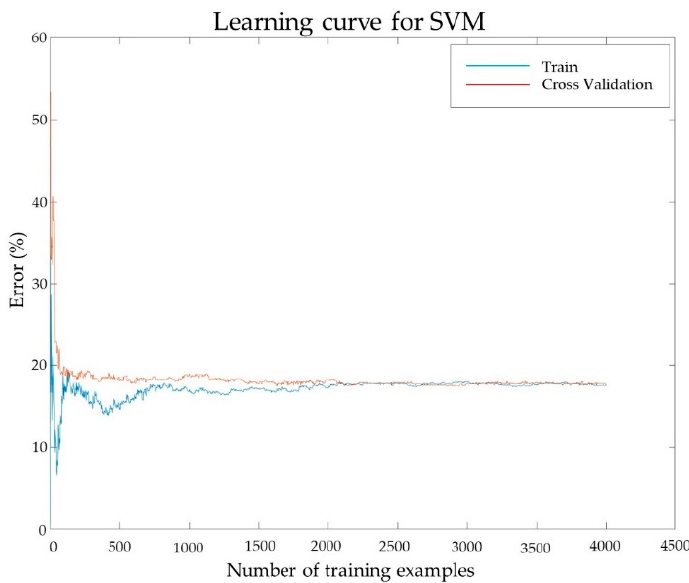
Figure 4. SVM 4 learning curve.